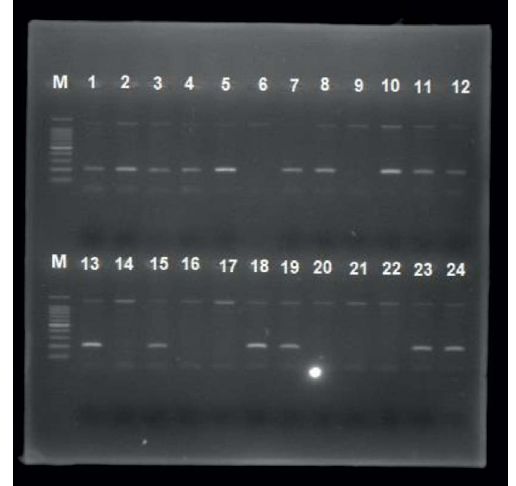
Fig. 2 . Gel electrophoresis for PCR product of P53 gene polymorphism (proline) M ladder, lane 1, 2, 3, 4, 5, 7, 8, 13, 15,18, 19, 23, 24 positive results lane 6, 9,